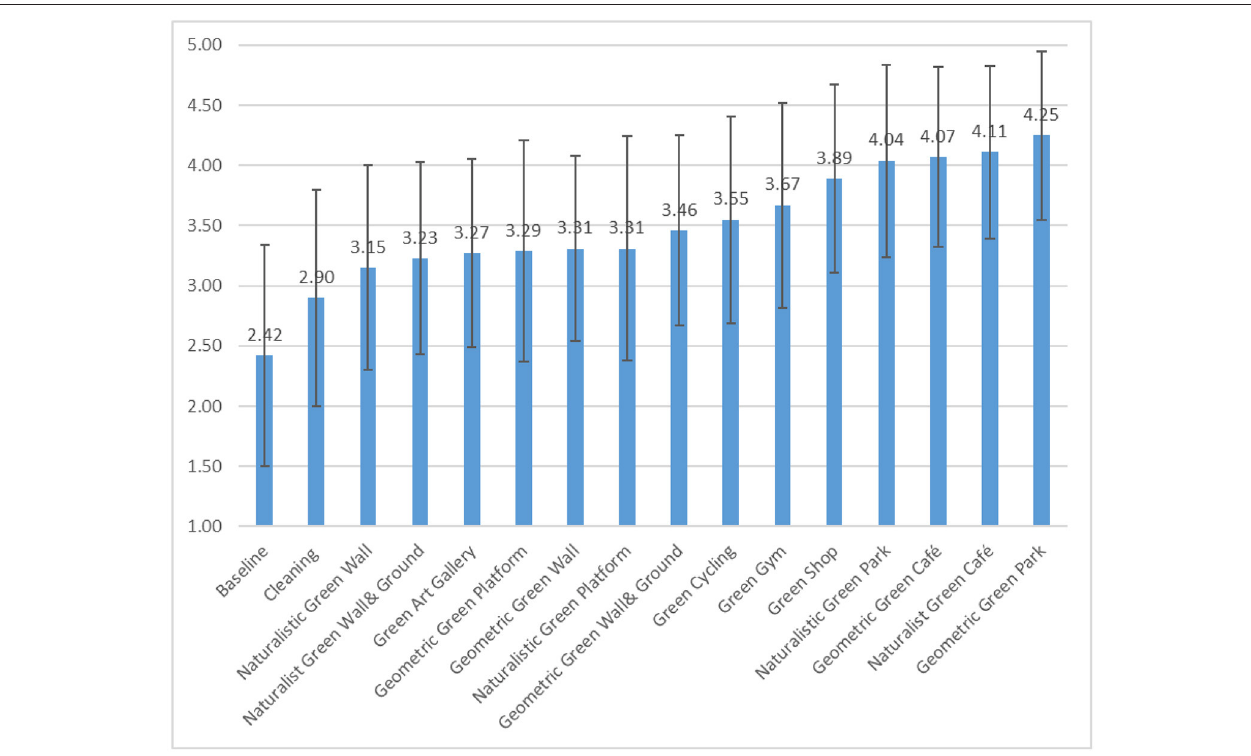
FIGURE 5 | Average perceived safety of the baseline and intervention scenes ranging from low to high scores. Compared to the baseline, all interventions yielded significant promotion on perceived safety but effect size varies. Error bars represent ± 1 standard deviation.